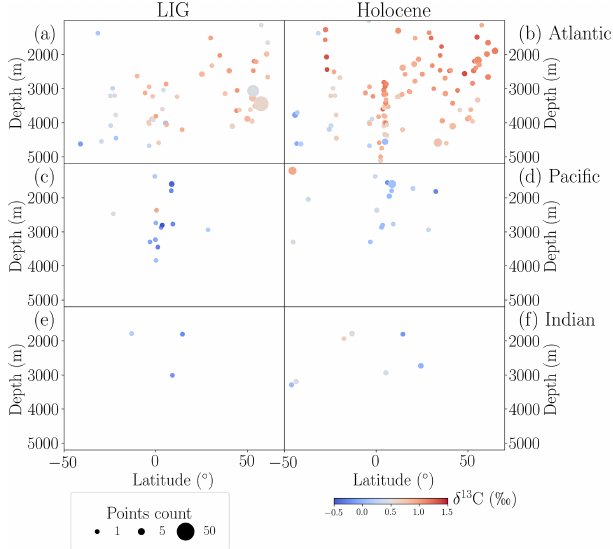
Figure 3. Zonal distribution of benthic foraminifera δ 13 C (‰) dur- ing the LIG (125–120kaBP; a, c, e ) and the Holocene (7–2kaBP; b, d, f ) in the Atlantic Ocean (a, b) , Pacific Ocean (c, d) , and Indian Ocean (e, f) . Symbol size indicates the number of measurements per core and colour indicates average δ 13